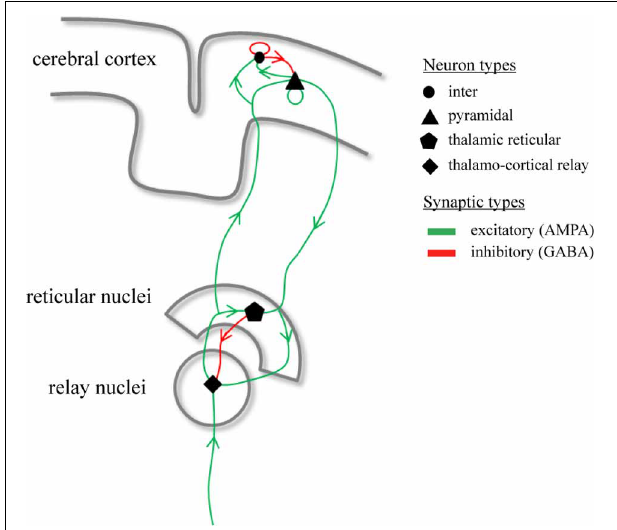
FIGURE 1 | Synaptic organization of the thalamo-cortical model. Illustrated are the synaptic pathways that connect the different neuronal populations within the model. The model contains four types of neuronal populations which are connected through excitatory (green) and inhibitory (red) synaptic